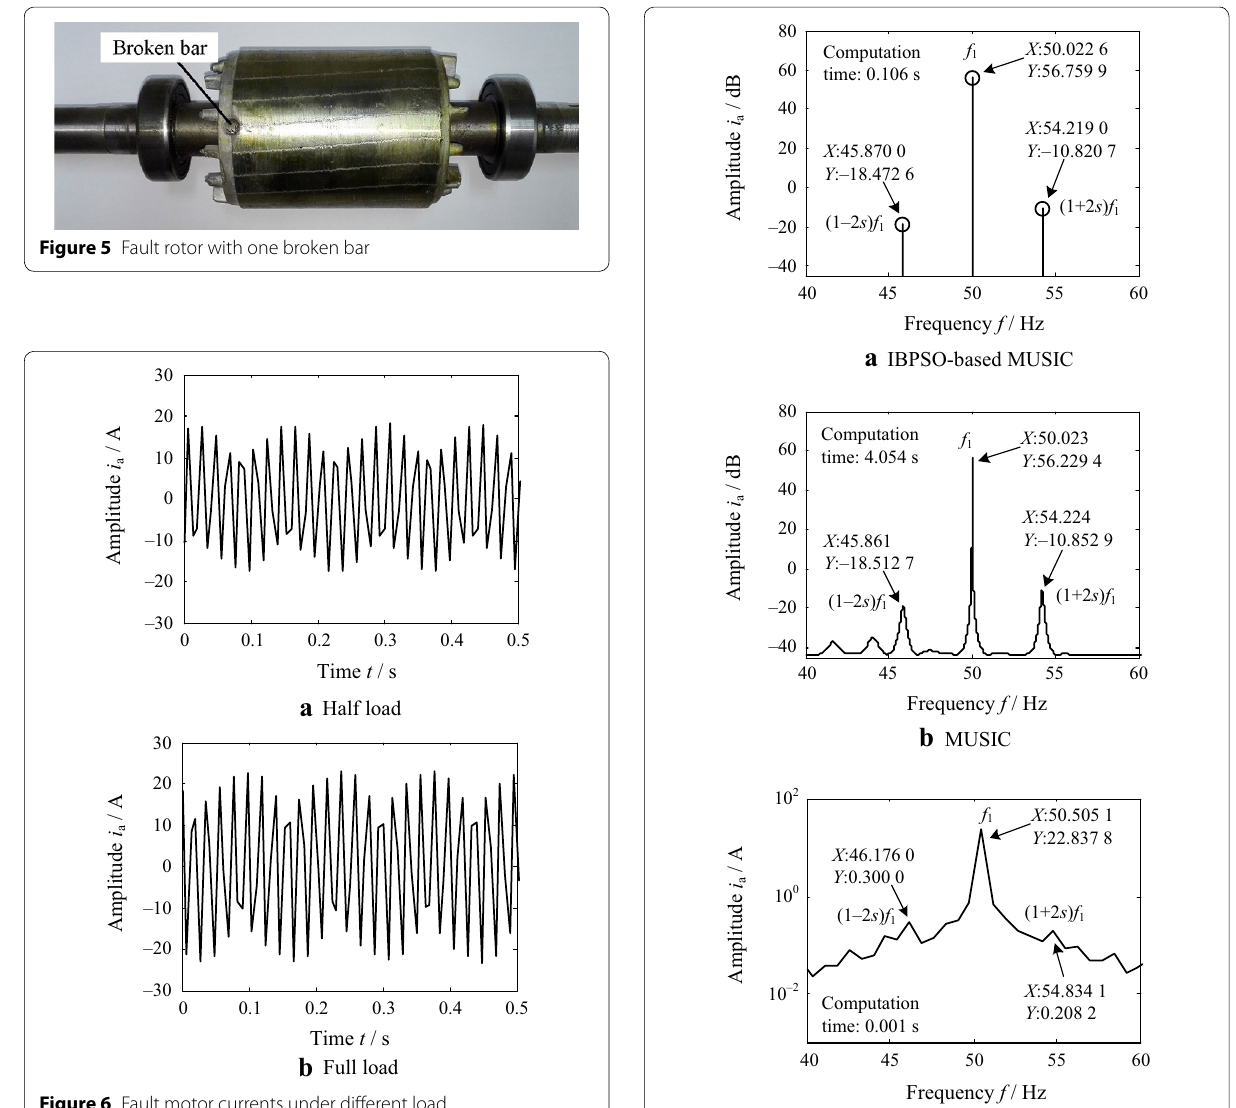
Figure 6 Fault motor currents under different load